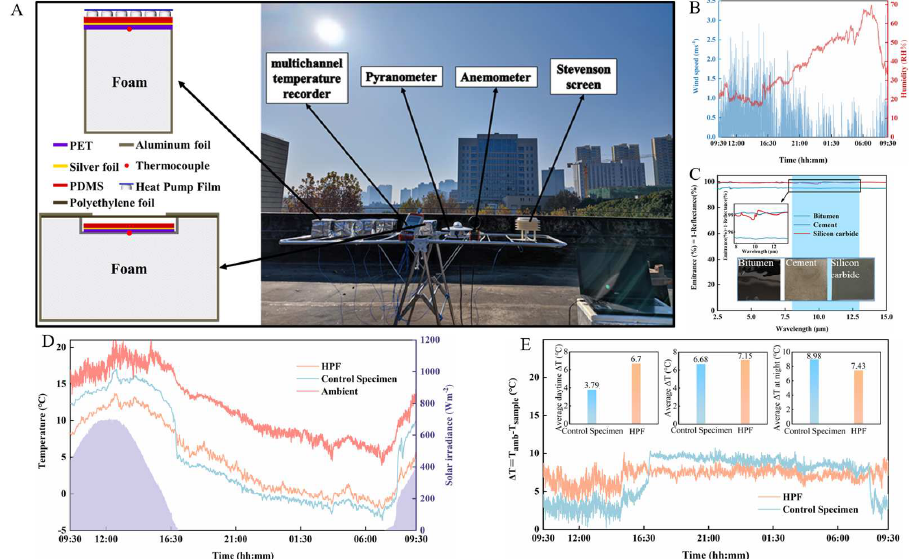
Figure 5. ( A ) Field test device, test location Wuhan, respectively, ambient temperature, sample temperature, wind speed, humidity, and solar radiation intensity, test device has temperature measurement device and control specimen device. ( B ) Wind speed and humidity testing during static roof testing. ( C ) Measured emissivity of building materials (bitumen, cement, and silicon carbide) over MIR wavelengths. ( D ) Sample temperature and ambient temperature testing under setup and control specimen setup, as well as real-time solar intensity testing. ( E ) Temperature variation of static roof test between device samples and control device specimen.